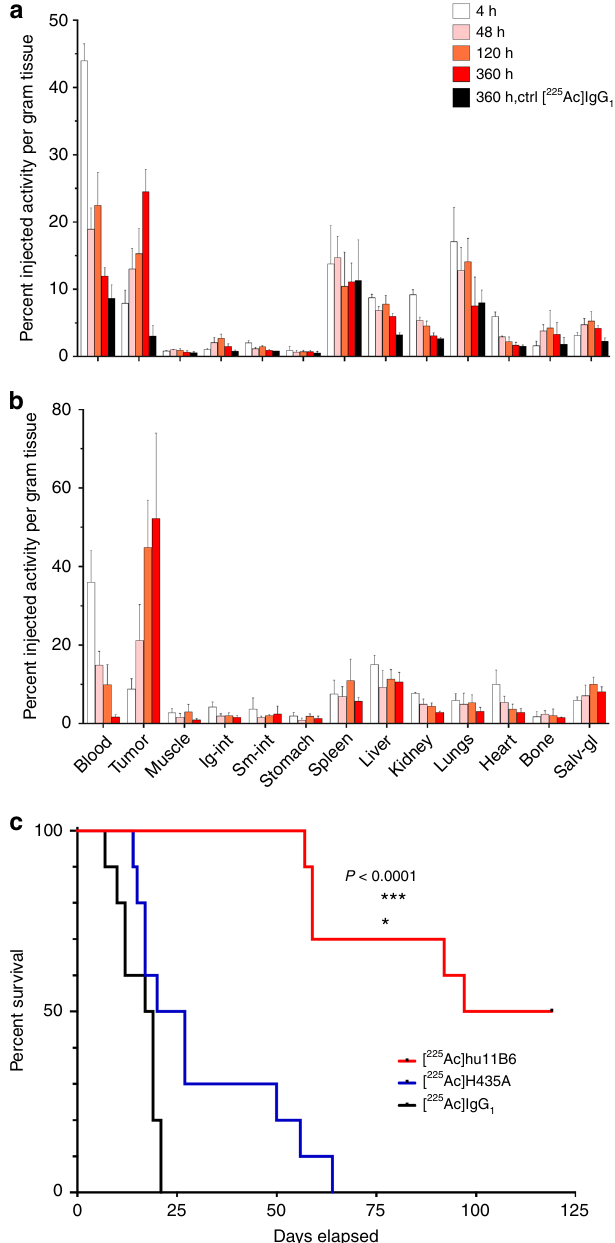
Fig. 1 Pharmacokinetics and pharmacodynamics of [ 225 Ac]hu11B6 in xenograft models of prostate cancer. Full [ 225 Ac]hu11B6 biodistribution data set of ( a ) LNCaP-AR and ( b ) VCaP s.c. xenograft models, where the signi fi cantly higher tumor accumulation of [ 225 Ac]hu11B6 can be noted in the VCaP model as a result of higher target expression. c Kaplan – Meier plot comparing survival of LNCaP-AR s.c. tumor models ( n = 10 per group) treated with a single 300 nCi dose of [ 225 Ac]hu11B6 (red line), 300 nCi